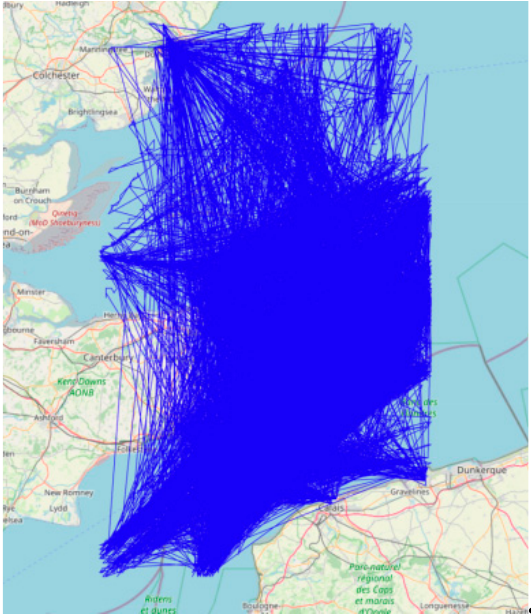
Figure 4. The raw AIS data in the Strait of Dover.